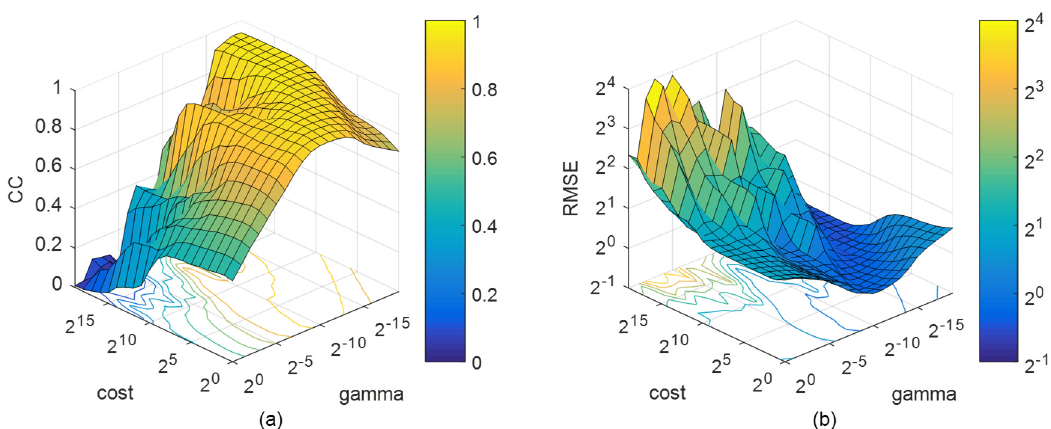
Figure 5. Grid search for kernel parameters in Support Vector Machine (SVM) regression. ( a ) correlation coefficient (CC); (b) root mean square error (RMSE).